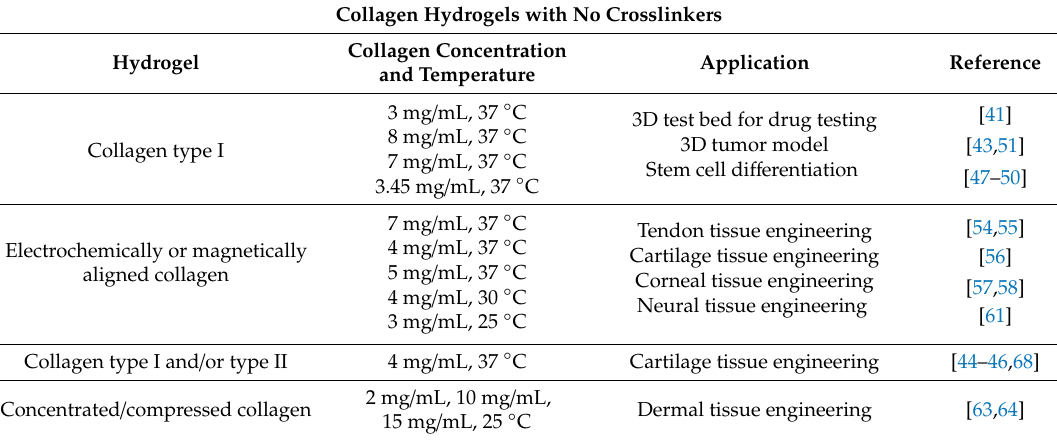
Table 1. Examples of collagen-based hydrogels and their